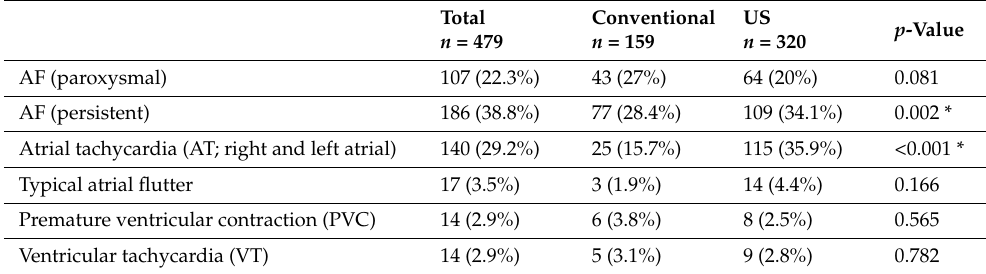
Table 2. Type of